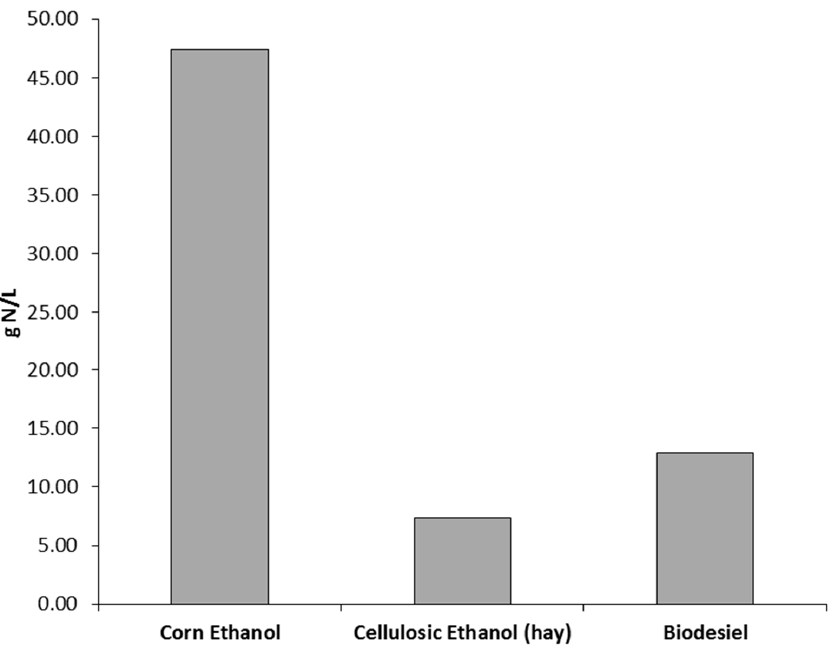
Figure 4. Total nitrogen flux and land requirements per volume of fuel.